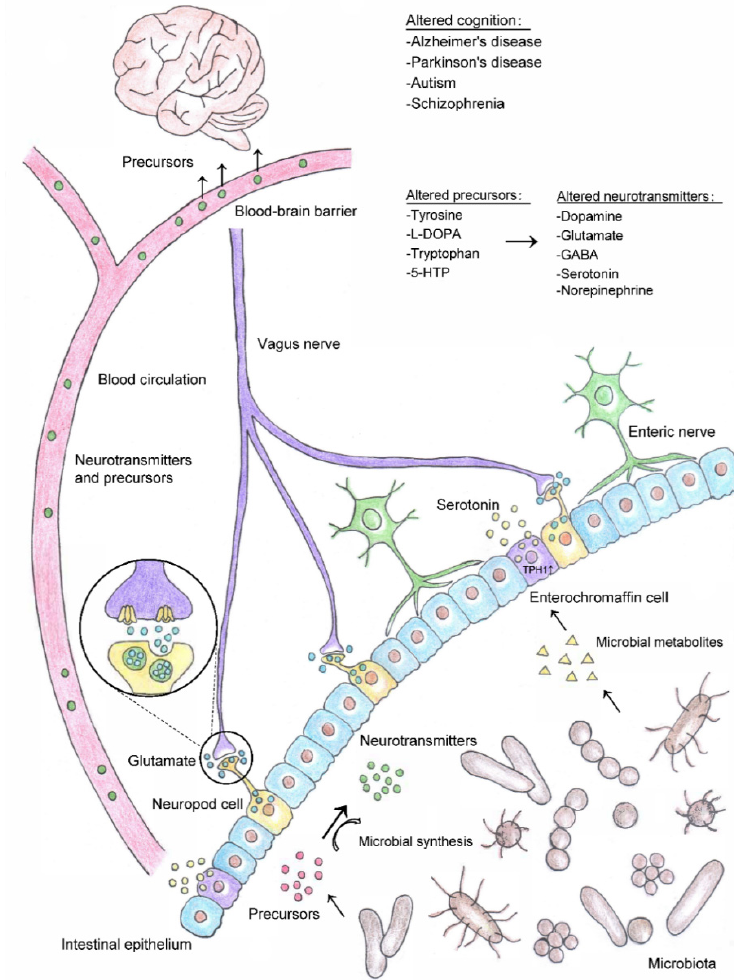
Figure 1. Gut microbial-mediated neurotransmitter synthesis and its impacts on cognition. Gut mi- crobiota can either produce neurotransmitter precursors, catalyze the synthesis of